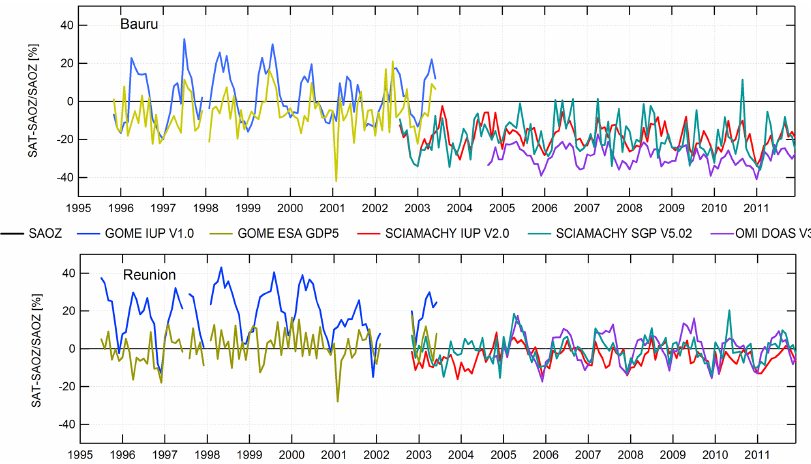
Figure 14. NO 2 relative mean difference of satellite data with SAOZ in % over Bauru (top) and Reunion (bottom). GOME GDP5 (green), GOME IUP V1 (blue), SCIAMACHY IUP V2 (red), SCIAMACHY SGP5 (dark green), OMI DOAS V3 (purple) and SAOZ sunrise